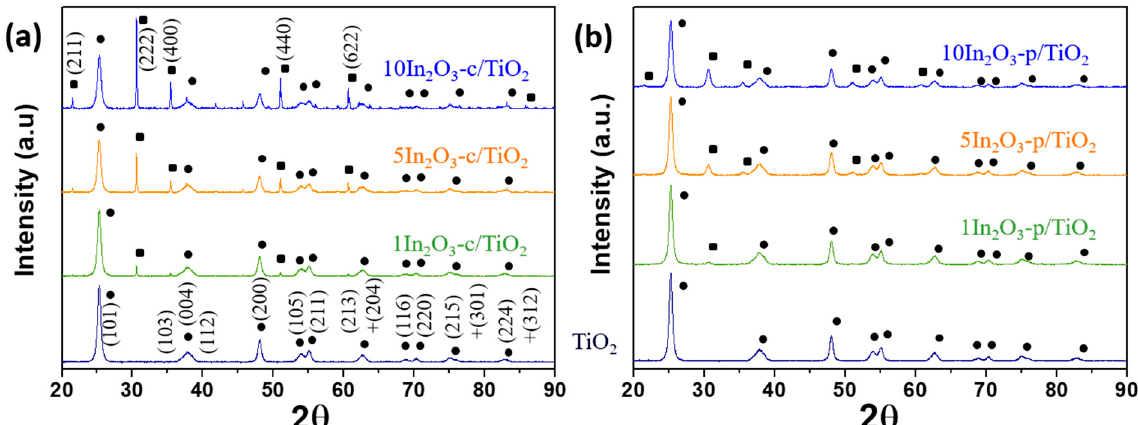
Figure 1. X-ray diffractograms of ( a ) c-series and ( b ) p-series catalysts. The identified phases are di ff erentiated with symbols: ● TiO 2 (ICCD-PDF: 01-084-1286) and ■ In 2 O 3 (ICCD-PDF: 01-071-2195), and their Miller indices are included.